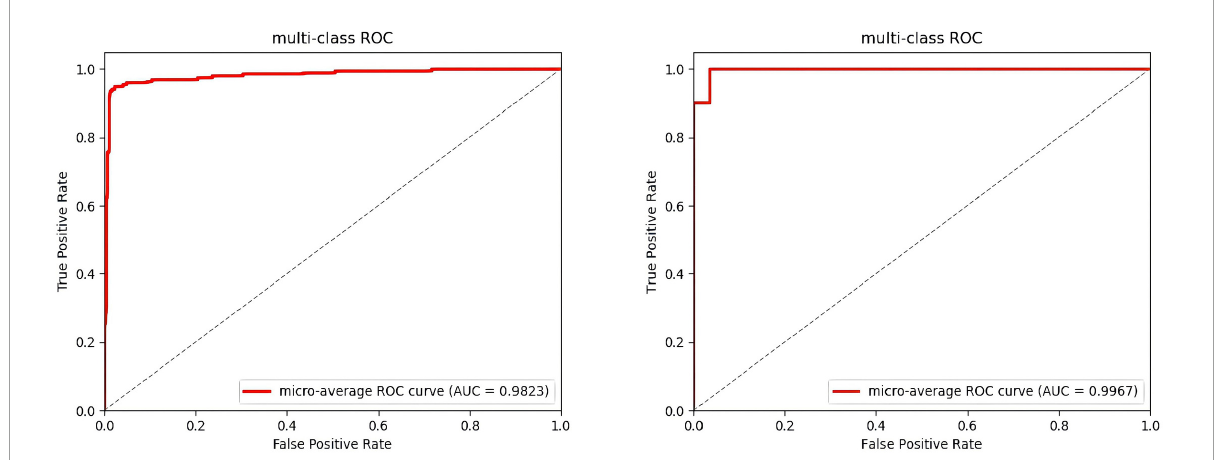
FIGURE6 Average ROC of the four-classes. (The ROC of the DEAP in the left, the ROC of the SEED-IV in the right).